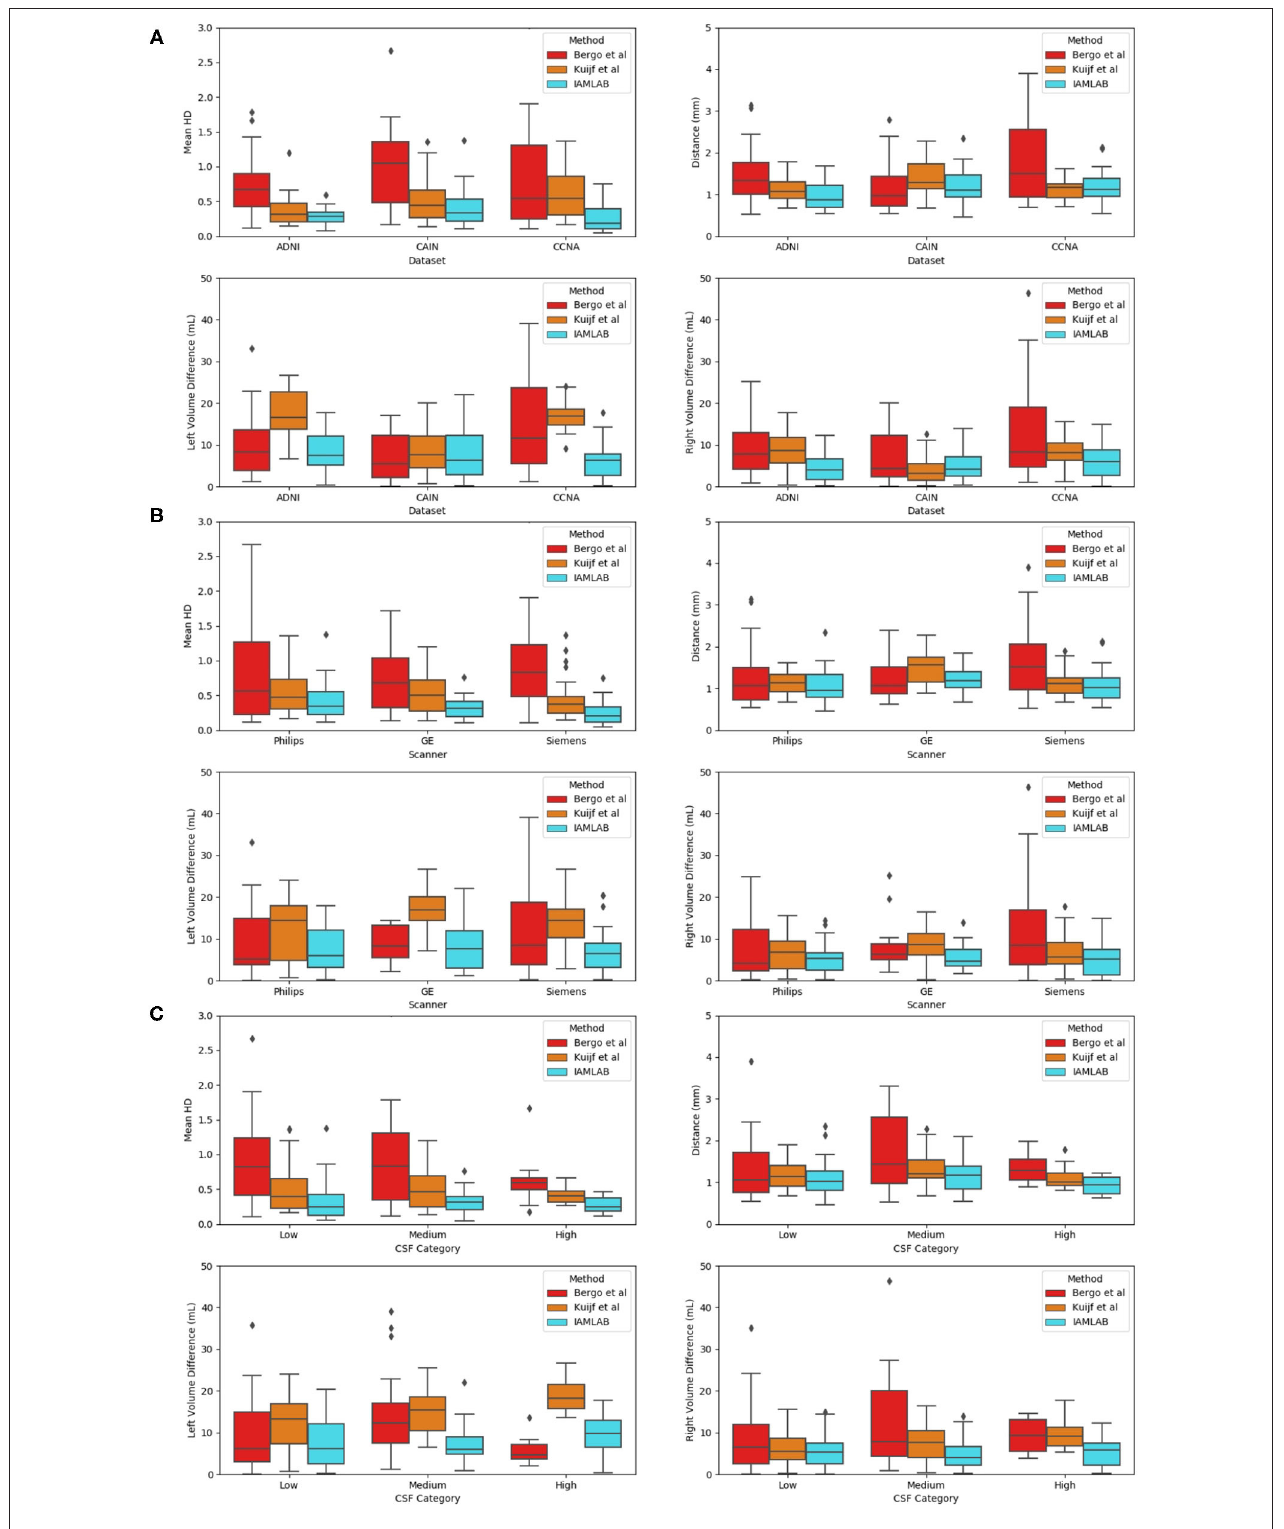
FIGURE 7 | Validation metrics as a function as a function of (A) dataset, (B) scanner, and (C) CSF load.